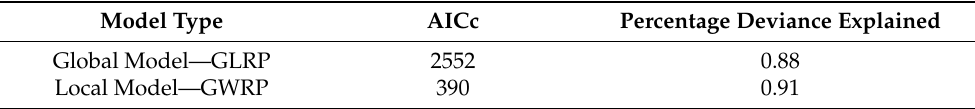
Table 2. Comparison of model performance.